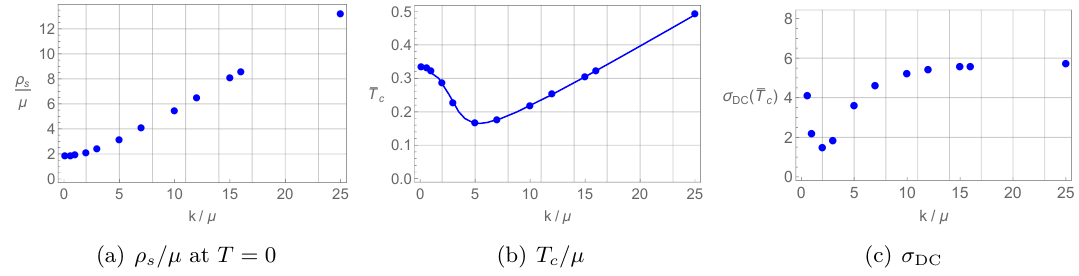
√ 3 . ¯ T c is the shorthand notation for T c /µ . The blue solid